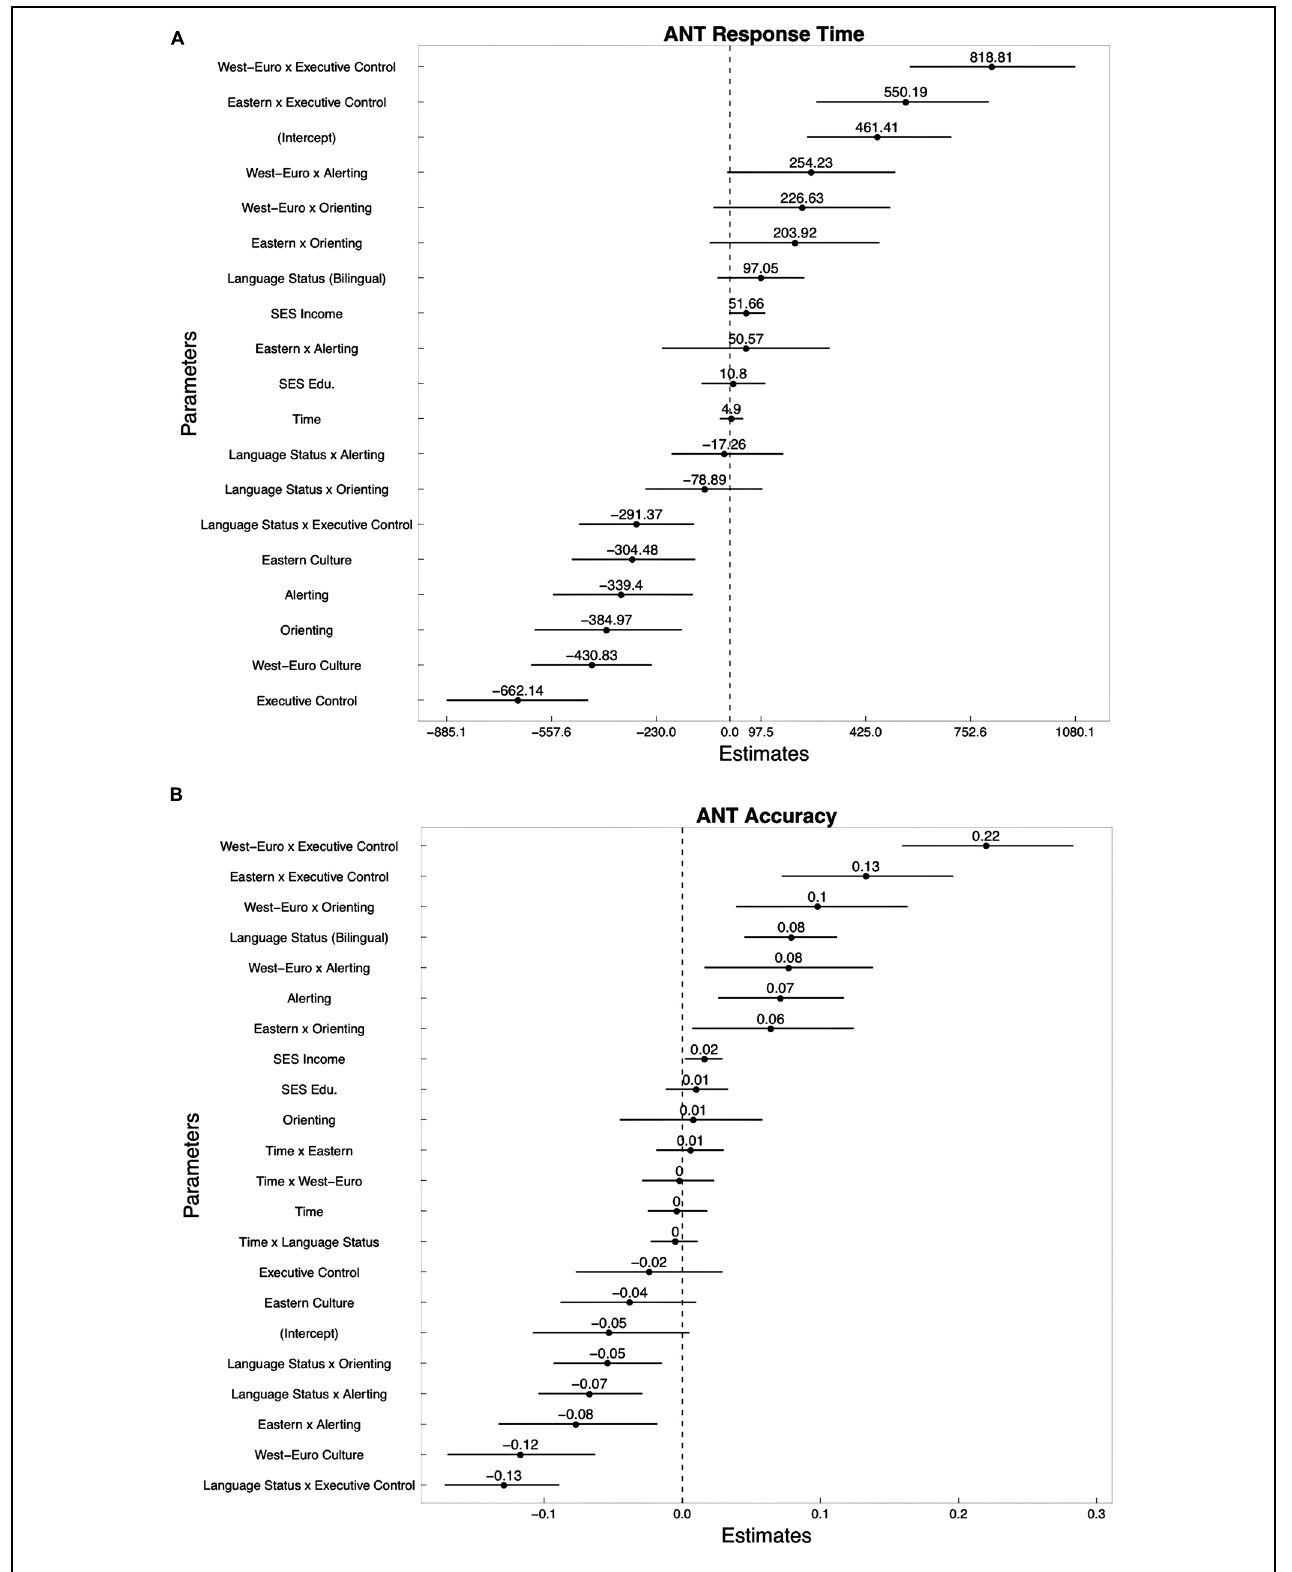
FIGURE 3 | Coefficient (parameter estimates) plots for the model of best fit on the ANT for (A) Response Time and (B) Accuracy.